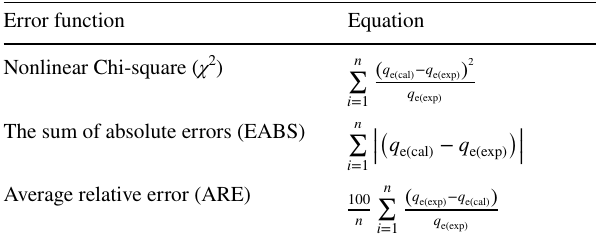
q e(cal) are model calculated values,